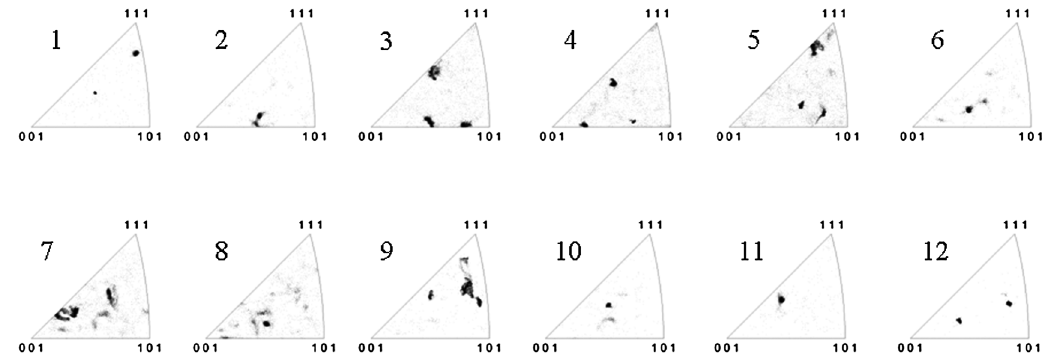
FIG. 12. Nb [001] IPF obtained by EBSD measurements on all samples.